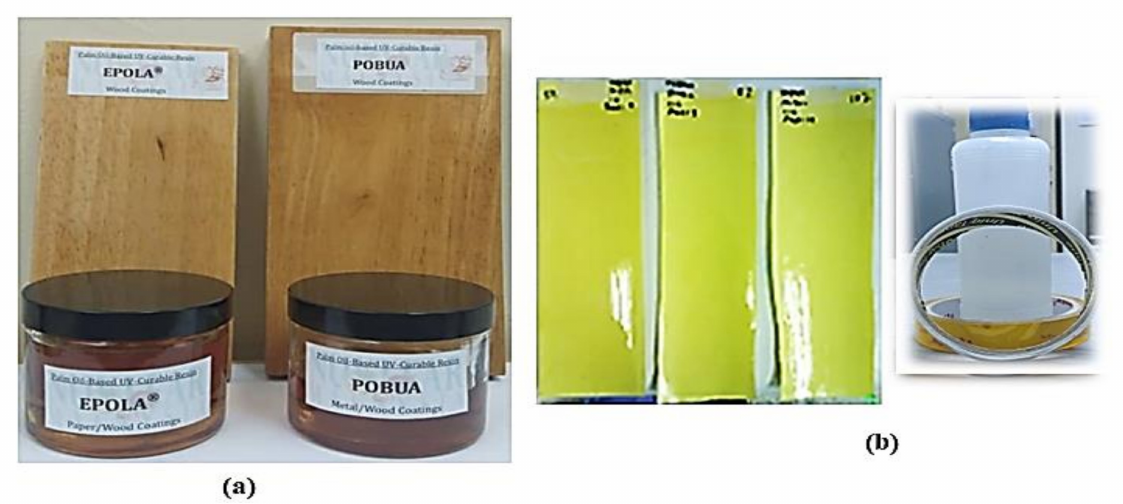
Figure 10. Radiation-curable of palm oil-based products with UV curing. ( a ) Acrylated and polyurethane resins for wood coating; ( b ) Polyurethane resins for PSA. Source: Unpublished